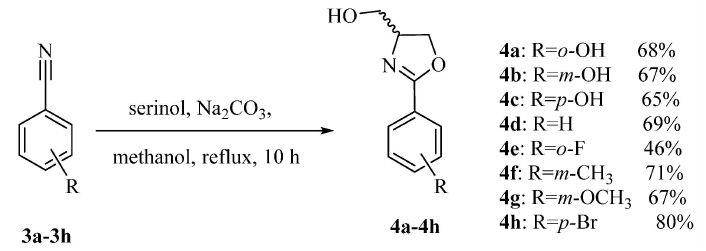
Scheme 1. The synthetic route of ( ˘ )-Yanglingmycin and its